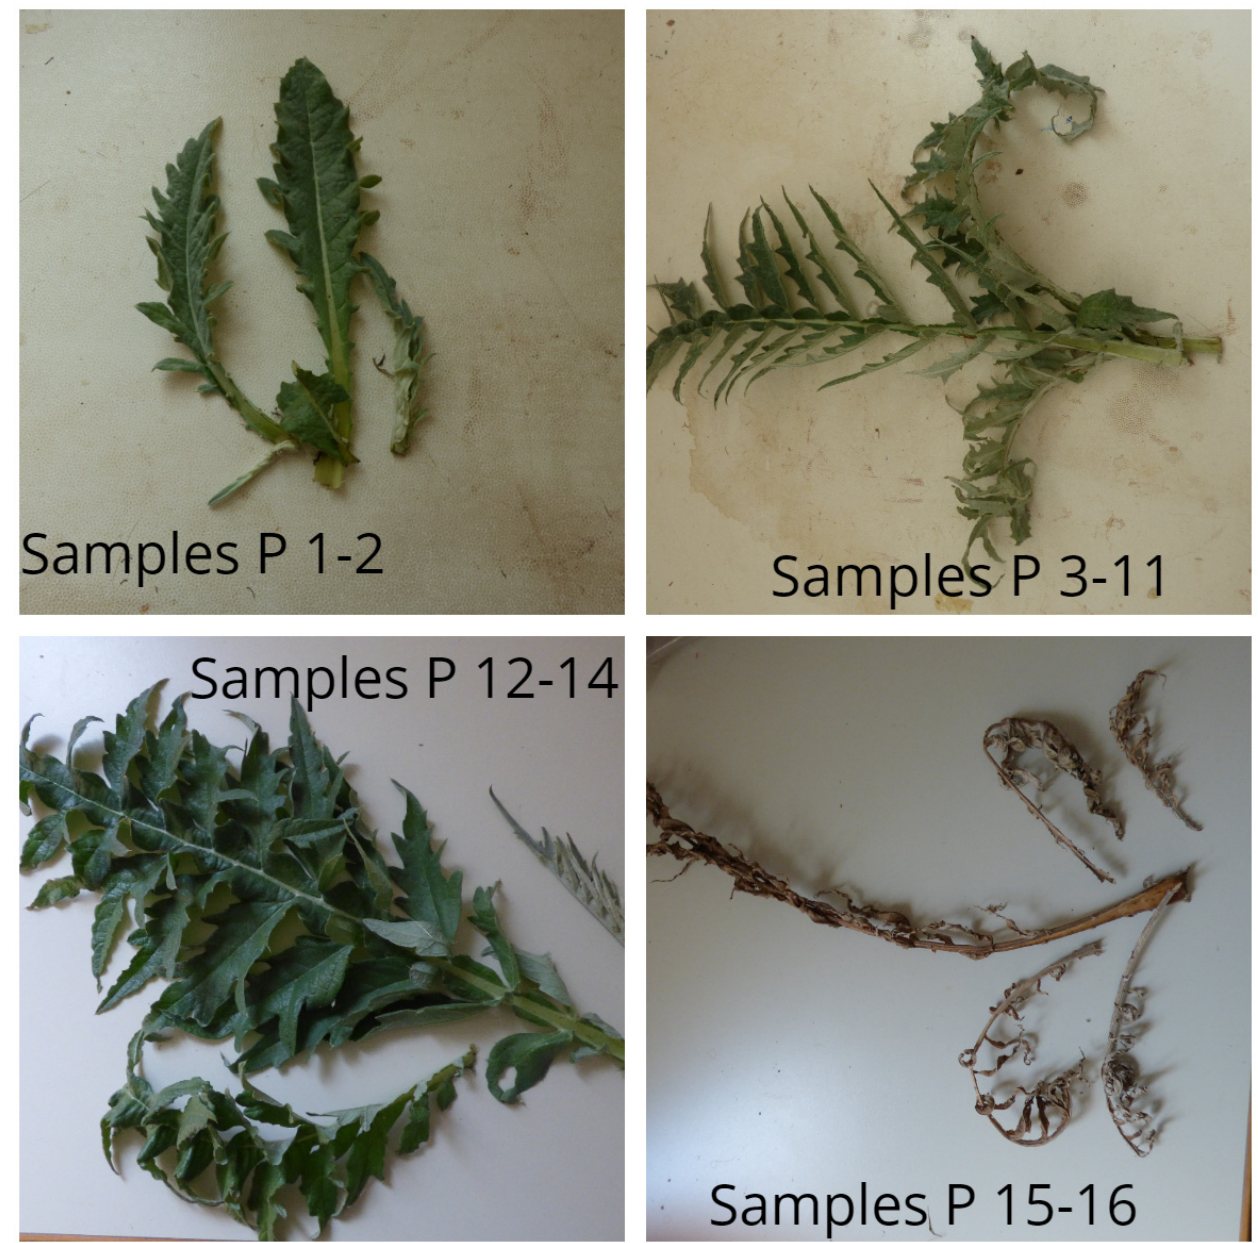
Figure 1. Leaf morphology at different harvesting stages (Sample P 1–16). Photo credits: Petropoulos S.A. (personal rec- ord).